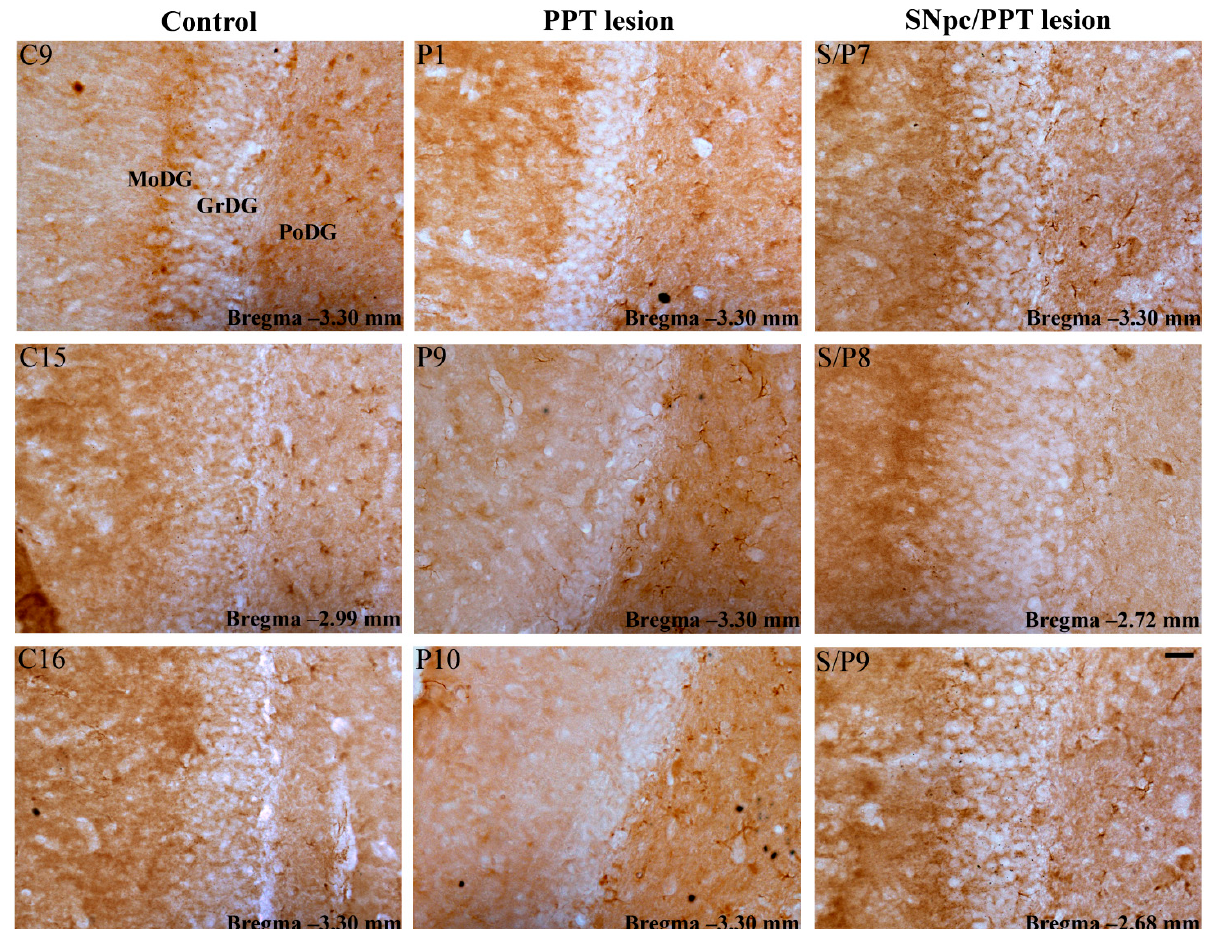
Figure 9. Alteration of PSD-95 immunostaining within the hippocampal DG in the distinct rat models of PD neuropathology. PSD-95 immunoreactivity within DG of the control rats (Control, C9, C15, C16), the rats with PD cholinopathy (PPT lesion, P1, P9, P10), and the hemiparkinsonian rats with PD cholinopathy (SNpc/PPT lesion, S/P7, S/P8, S/P9). MoDG—molecular layer of the dentate gyrus; GrDG—granule cell layer of the dentate gyrus; PoDG—polymorph cell layer of the dentate gyrus. Scale bar is 25 µ m. Whereas PSD-95 immunoreactivity was suppressed in the rats with PD cholinopathy, it was enhanced in the hemiparkinsonian rats with PD cholinopathy within the granular cell and molecular layers of DG vs. the control rats.